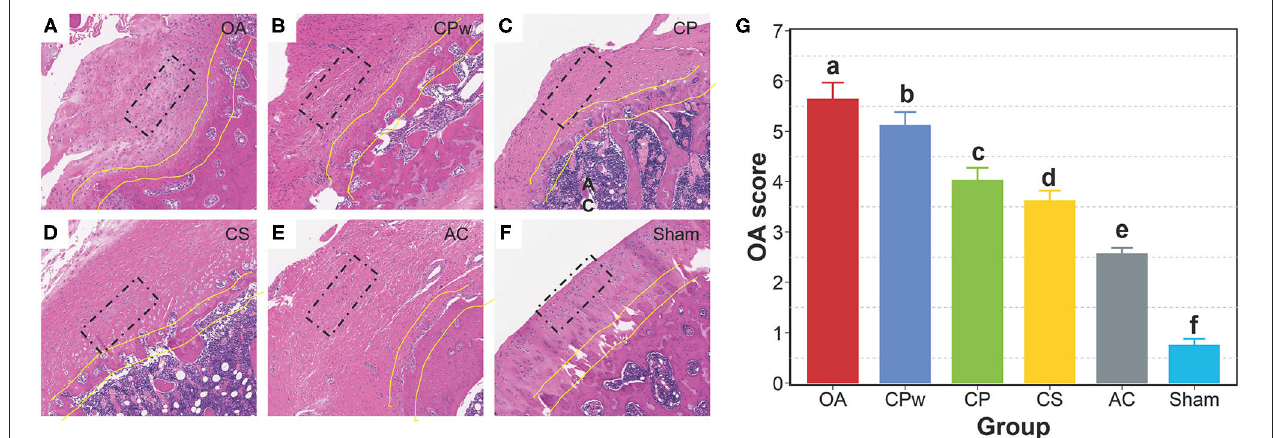
FIGURE 3 | Morphological observation of cartilage tissue. (A–F) The H&E staining images of the OA, CPw, CP, CS, AC, and sham groups, respectively. (G) The OA score by the Mankin’s score. The cell morphology is inside the black rectangle. The tide line is between the two yellow lines. The different letters mean the significant difference between the two groups.